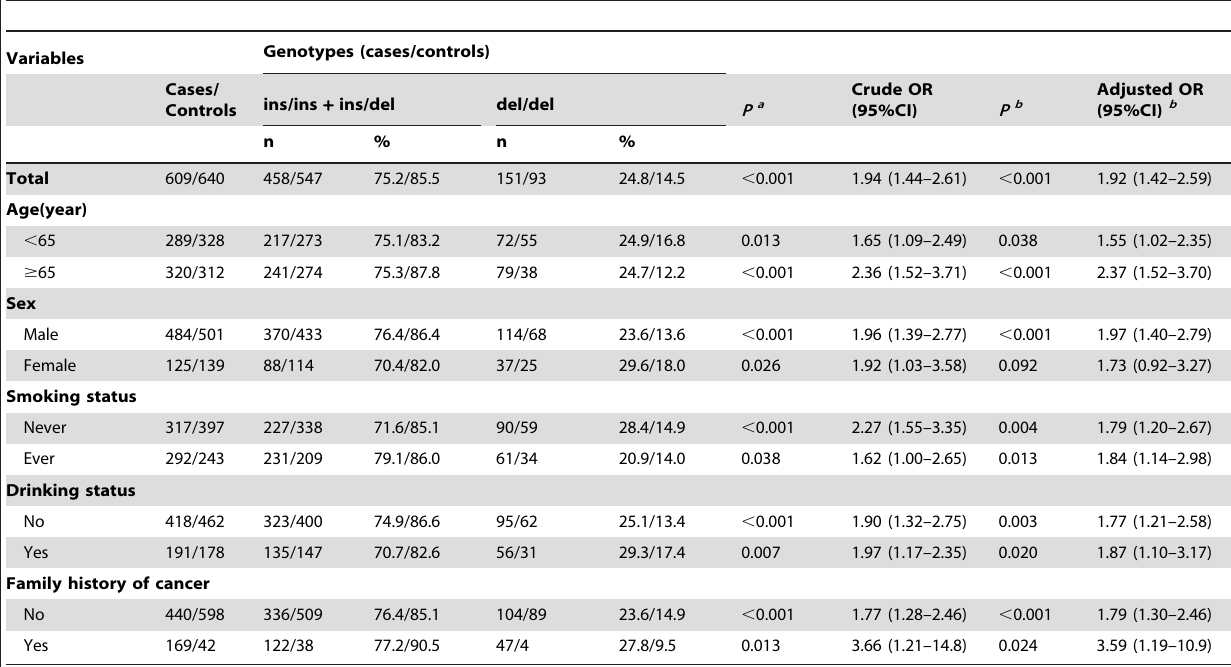
Table 3. Stratification analyses between NFKB1 promoter –94 ins/del ATTG polymorphism and risk of bladder cancer.